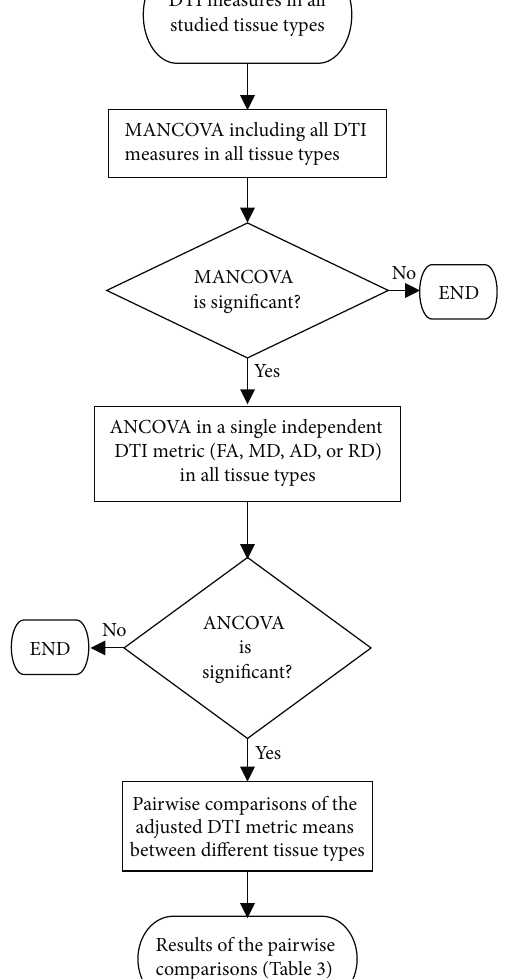
Figure 1: Flow chart of the statistical analyses conducted to identify DTI metric di ff erences between tissue